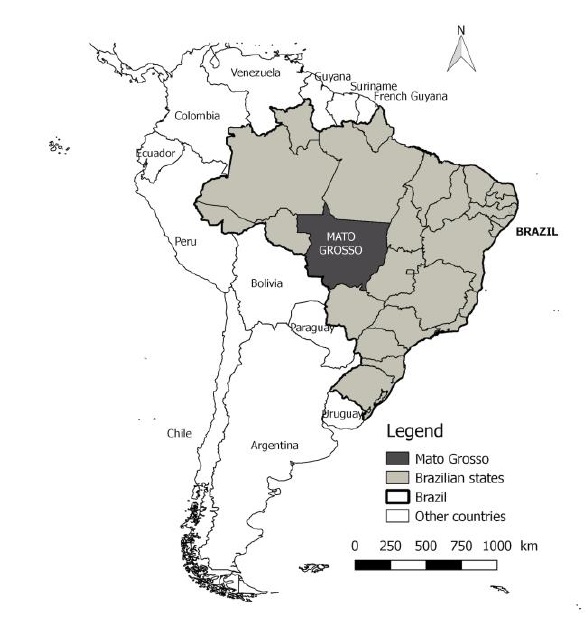
Figure 1. The location of Mato Grosso in Brazil